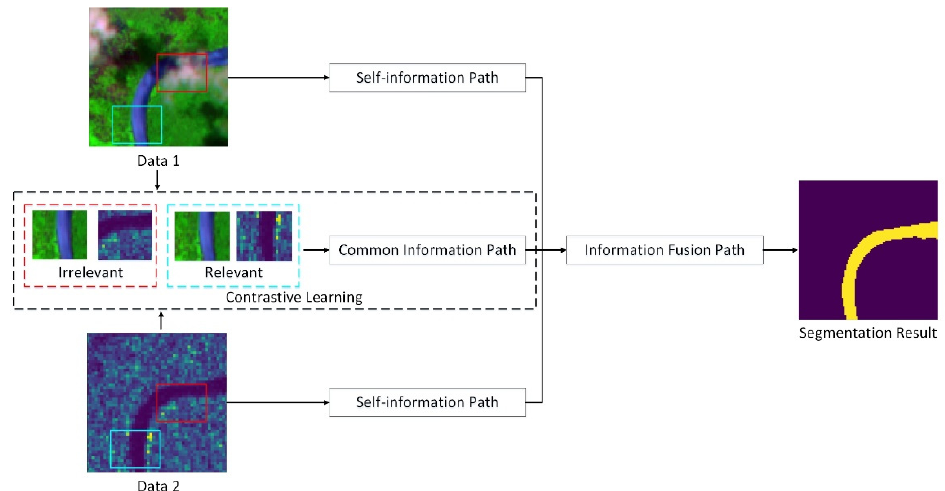
Figure 1. The proposed contrastive learning based multi-source data segmentation structure. The segmentation result is generated using the self-information and common information, extracting from the multi-source data pair, including Data 1 and Data 2. For the common information extracting process, the contrastive learning idea is to minimize the relevant image information embedding between the same location multi-source data. Here, the relevant image information are extracted from multi-source data pair of same location and the irrelevant image information are extracted from multi-source data pair of different location. Thus, the common information path can be more focused on the clear area of the image (without aerosol and cloud) and can guide the segmentation process, along with the self-information extracted from each multi-source data.